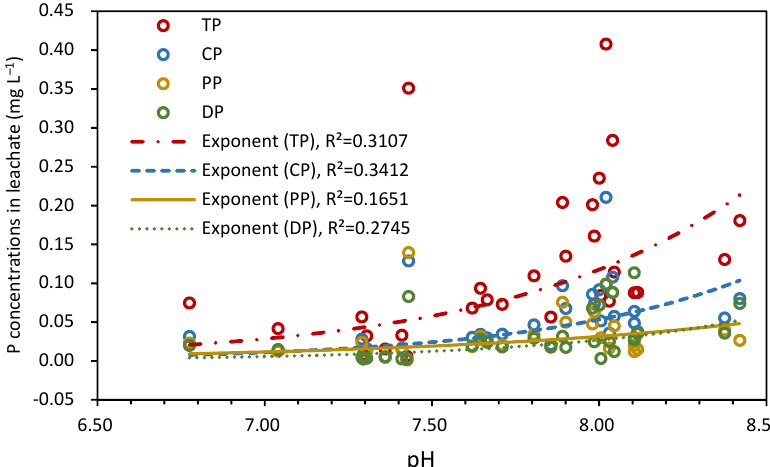
Figure 6. Relationship between total phosphorus (TP), colloidal phosphorus (CP), dissolved phos- phorus (DP), and particle phosphorus (PP) in leachate and pH. Curves represent fits of nonlinearity model to the data. All fitted lines are significant at the p < 0.01 level. Table 2. Coefficient of determination (R 2 ) for the relationship between the phosphorus (P) application rates and colloidal phosphorus (CP) and dissolved phosphorus (DP) of different soil layers. Correlation Coefficients (R 2 ) for P Application Rates with Soil Layers (cm) CP